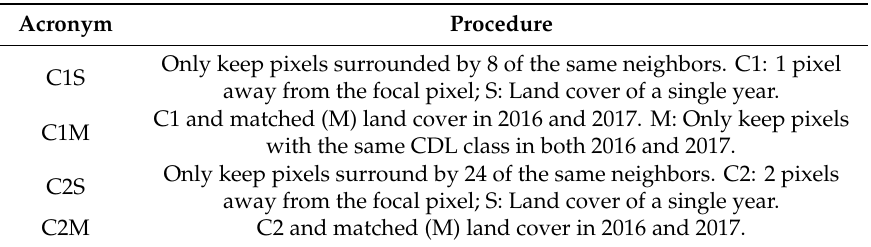
Table 3. Sample pool